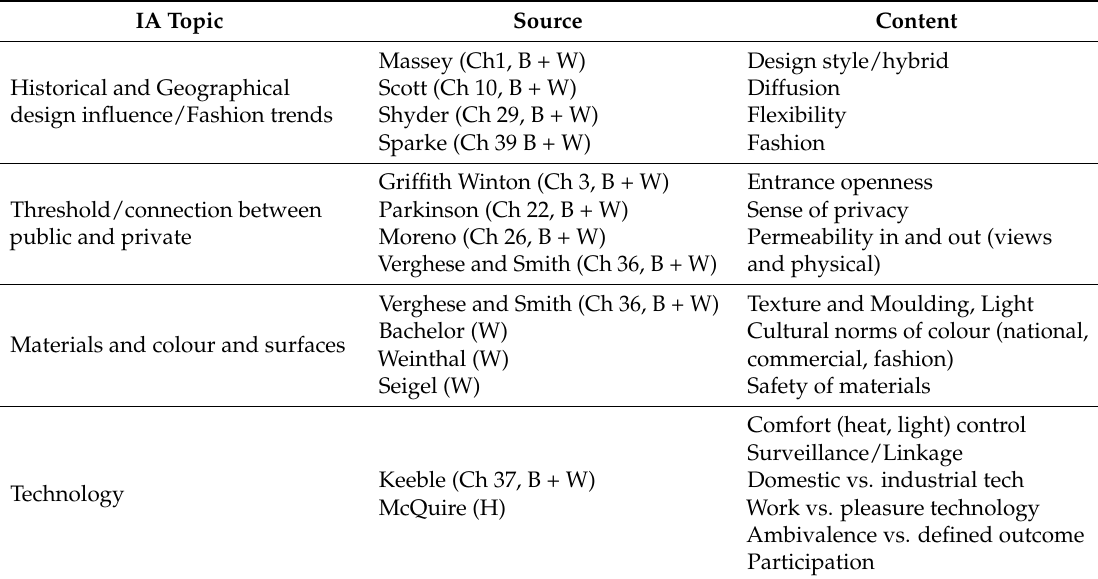
Table 2. Selected preliminary content analysis of selected key texts—interior